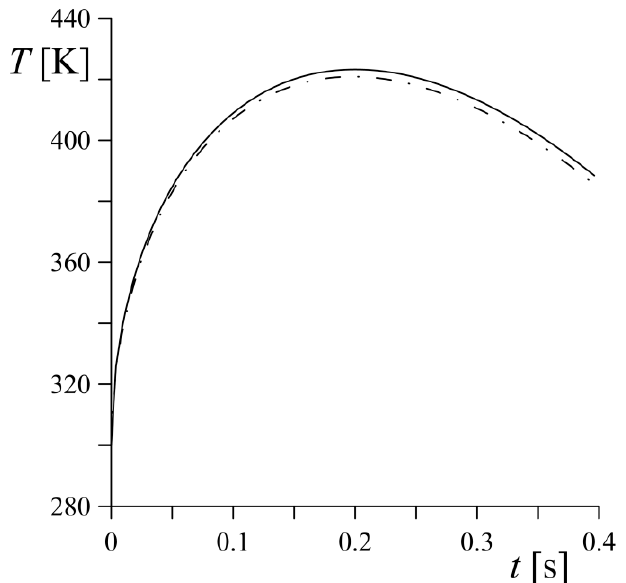
Figure 7. Highest surface temperature of clutch disc through the slipping time. Dotted–dashed line presents FE results and solid line presents analytical results (32), (38).